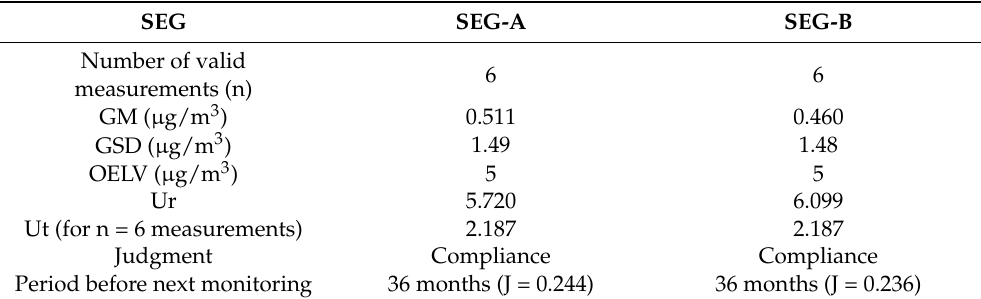
Table 6. OELV compliance test for Cr (VI) occupational exposure—Samples treated with the NIOSH extraction protocol (data in Table 4). GM: geometric mean; GSD: geometric standard